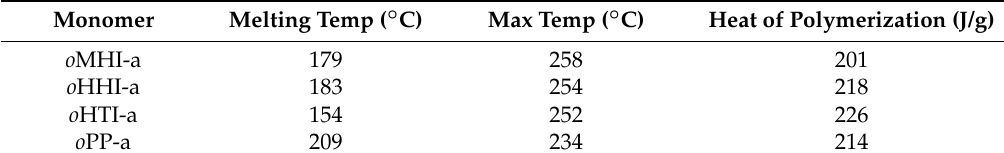
Table 1. DSC thermograms of benzoxazine monomers.